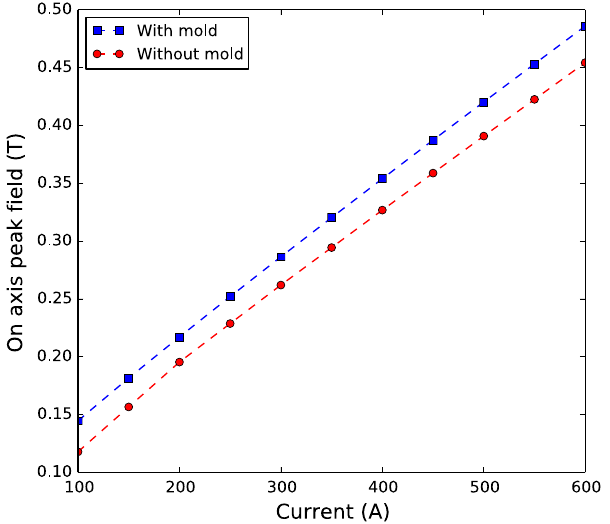
FIG. 25. The on-axis peak field achieved with the 31.5 mm short prototype HSCU with and without the 1020 steel mold.